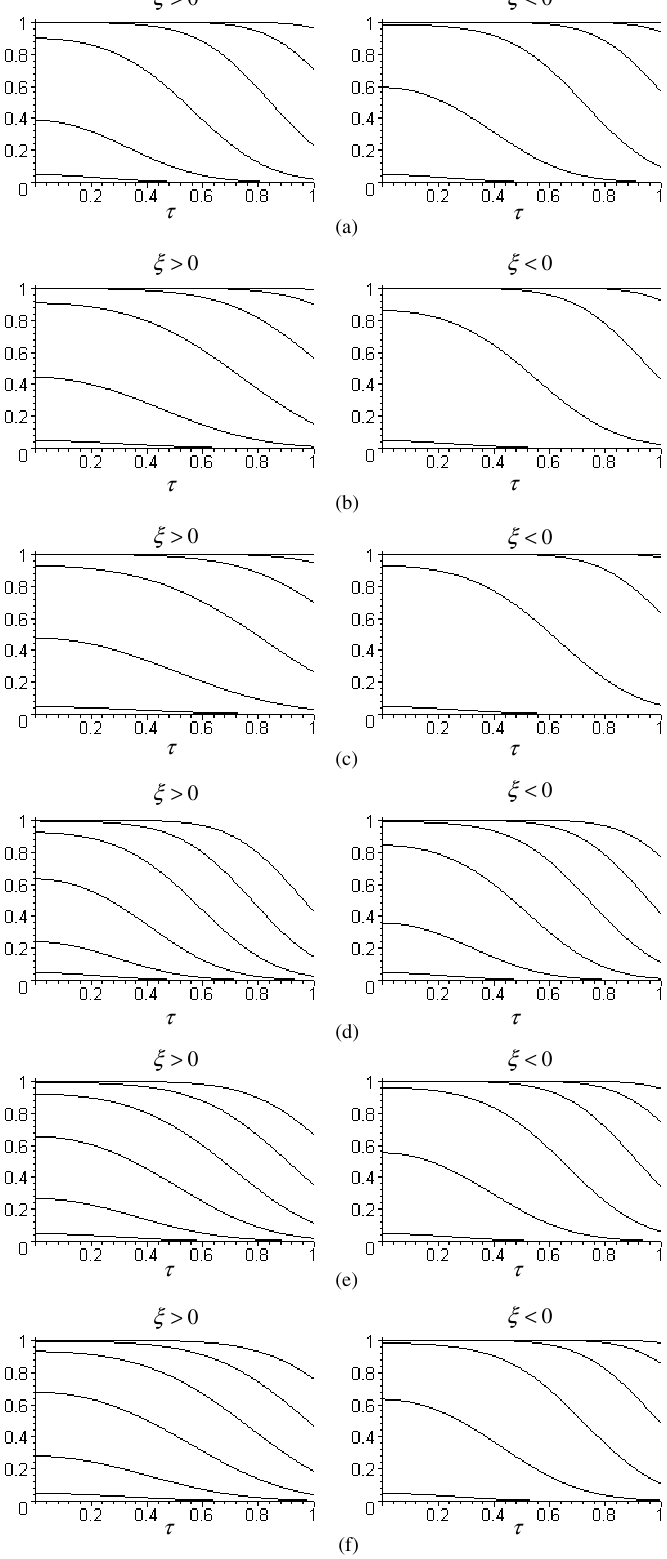
Fig. 2. Plots of π G versus τ with u = 0 . 5, v = 1 . 5, k = 3, n = 50, α = 0 . 05, C u p ( u, v ) = c (0 . 20)( c + 1) (bottom to top) for (a) c = 1 and C u C u u, v ); (b) c = 1 and C u p = p ( (e) c = 1 . 5 and C u p = C u p ( u, v ) + 0 . 33; (f) c = 1 . 5 and C u p = C u p ( u, v ) + 0 .